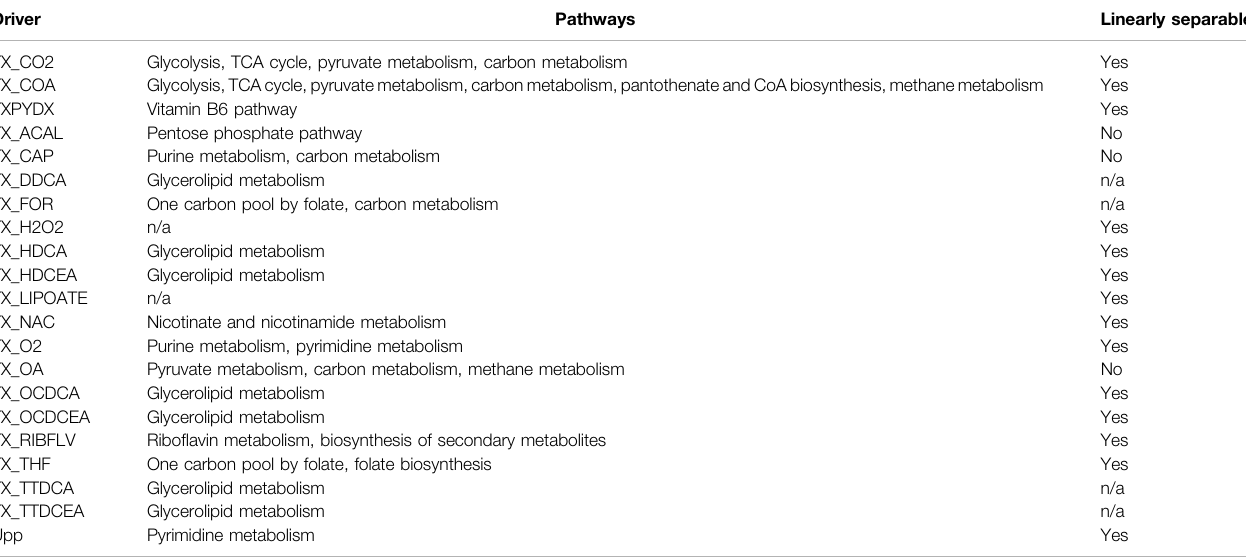
TABLE 3 | List of all of the driver nodes, whether they can linearly separate different phenotypic classes in the PCA space, and their associated pathways (if available). Driver Pathways Linearly